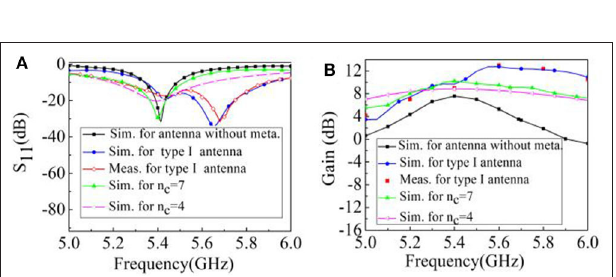
FIGURE 9 | (A) Return loss and (B) gain for type I antenna with different refractive index of core layer and the antenna without